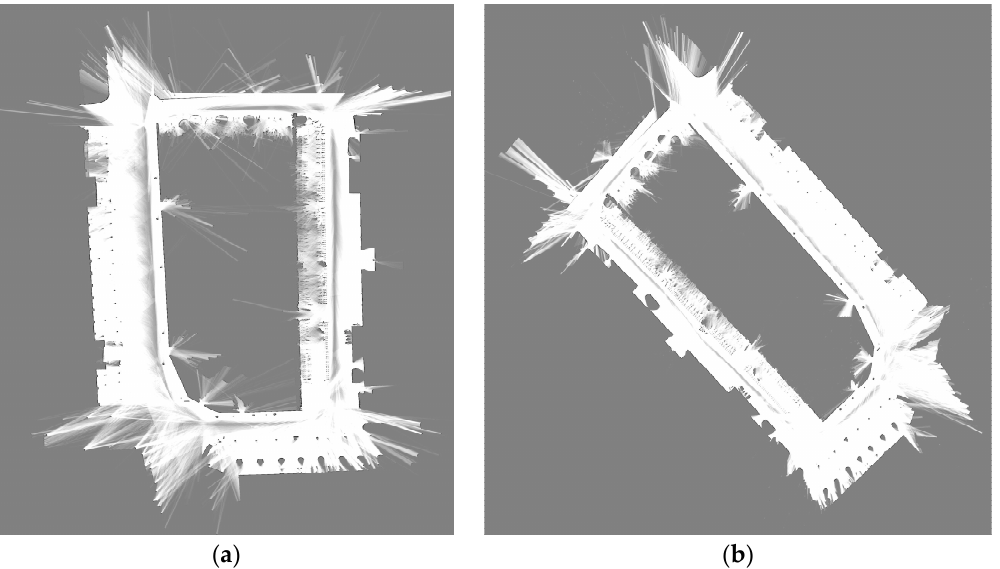
Figure 10. Closed-loop experiment in outdoor environment. ( a ) Cartographer (LiDAR only); ( b ) the proposed method.